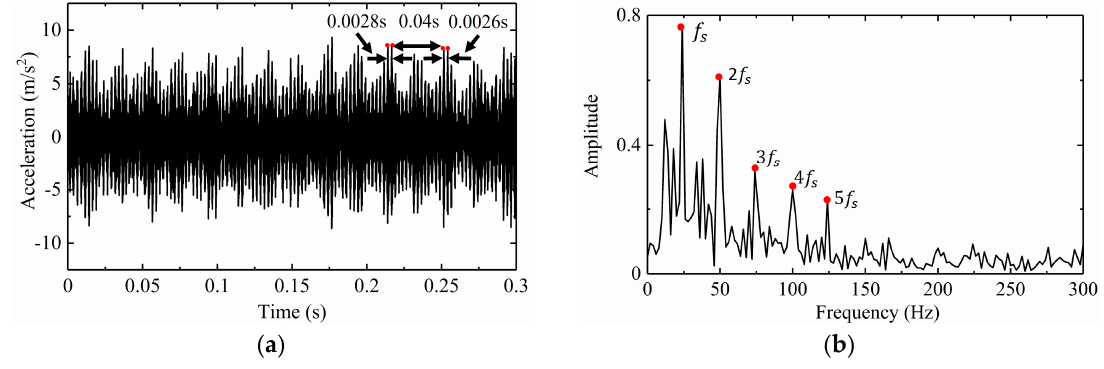
Figure 20. The results of an experimental signal by the proposed ALO-VMD method: ( a ) The time-domain signal and ( b ) the envelope